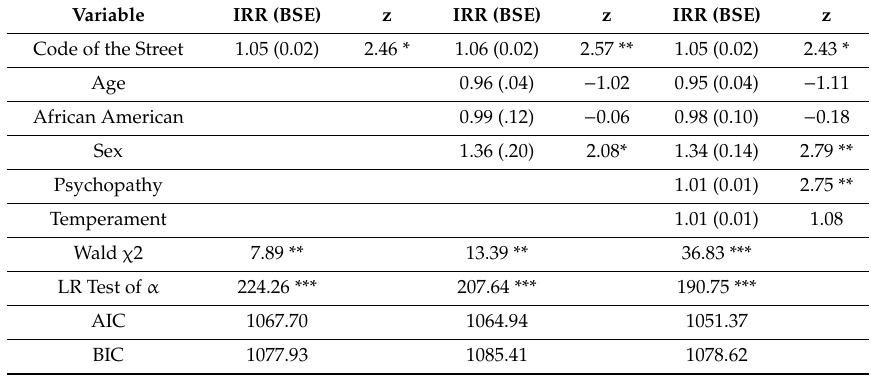
Table 1. Negative binomial regression models for self-reported arrests.